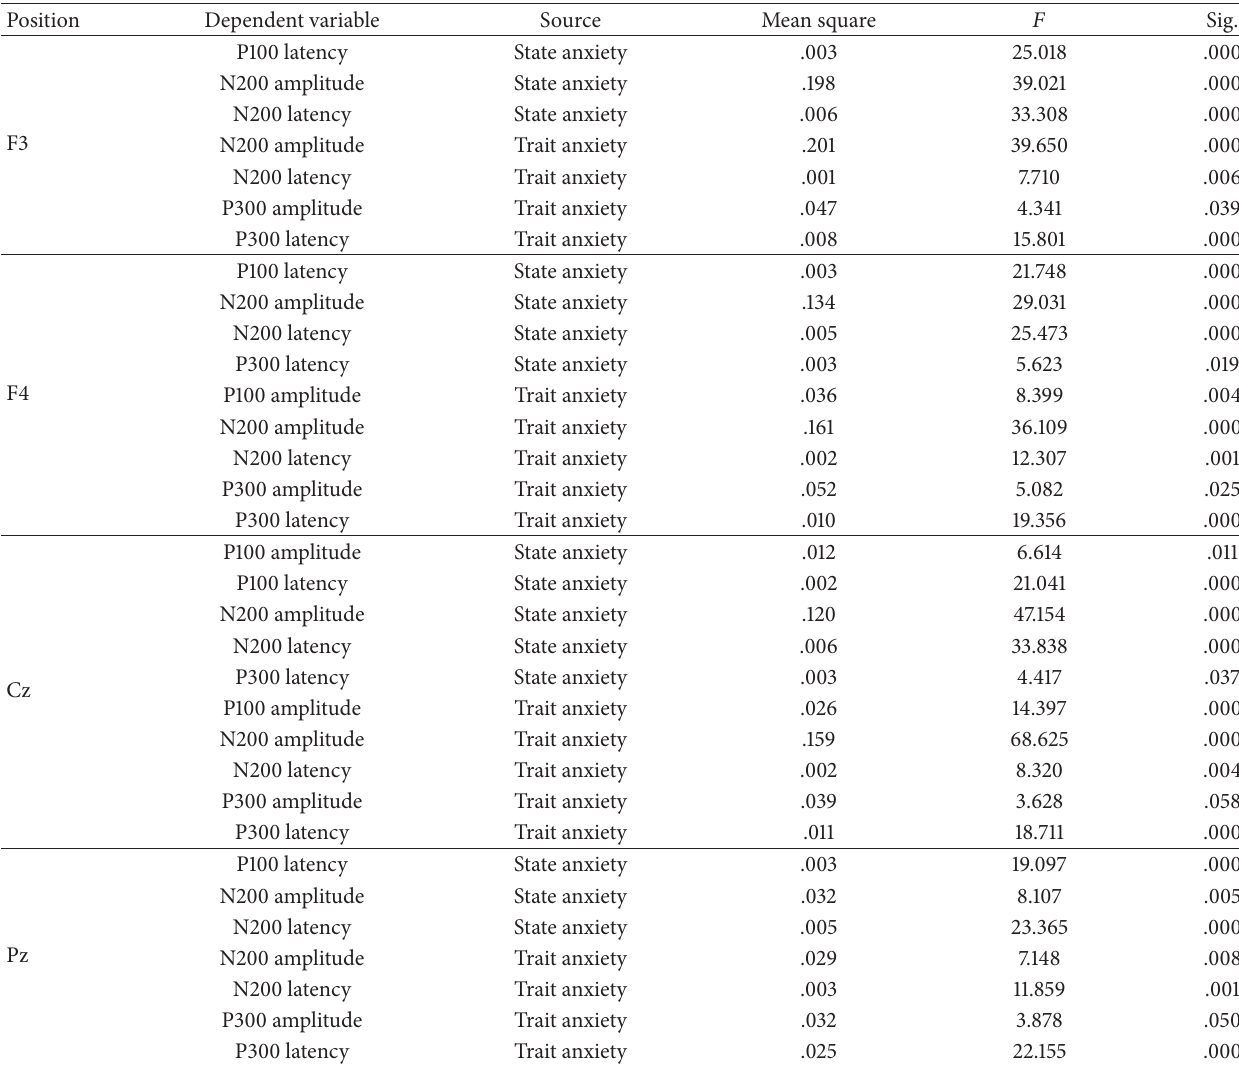
Table 2: Dependence between anxiety and ERP at